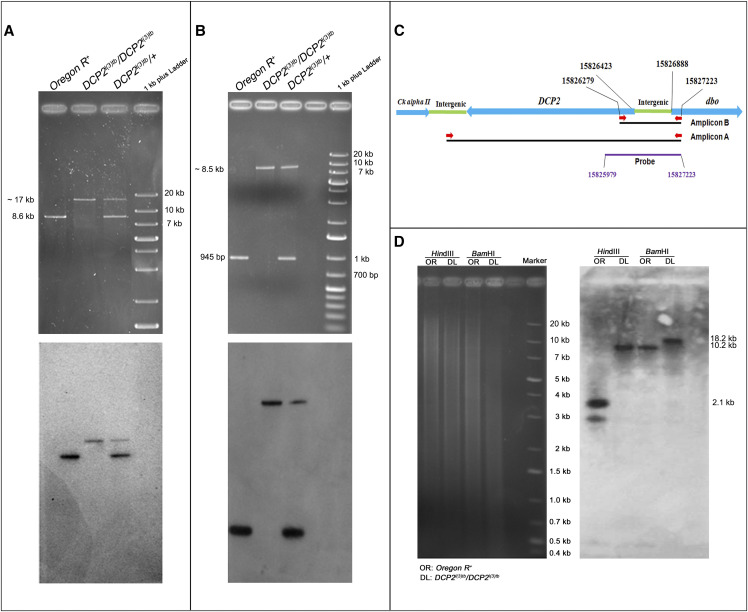
DCP2l(3)tb is an insertion allele of DCP2. Gel electrophoretogram showing the PCR analysis of the full-length DCP2 (A) and candidate region (B) in the wild type, mutant and the heterozygote. The schematic in C shows the gene arrangement along the chromosome along with the important coordinates. The primers are indicated by red arrows. Amplification of the full length gene shows that the wild type amplicon is of 8.6 kb while the mutant amplicon is sized ∼17 kb (A, upper half), whereas the wild type amplicon for the candidate region is of 945 bp while the mutant amplicon is sized ∼8.5 kb (B, upper half). The heterozygote harbors both the alleles (wild type and mutant) and thus shows both the amplicons. The lower half in both A and B shows the the blot of the same probed with the pGEM-T-812 probe which spans the candidate mutated region in DCP2 and is represented by the purple line. D shows the gel electrophoretogram and Southern blot of DCP2 in the wild type and mutant genome. HindIII digested genomic DNA showed banding at ∼2.1 kb in the wild type genome as against ∼10 kb in the mutant genome, the size difference being almost in agreement with the banding profile exemplified by BamHI digestion, with the wild type genome hybridizing at ∼10.2 kb and the mutant at ∼18 kb.